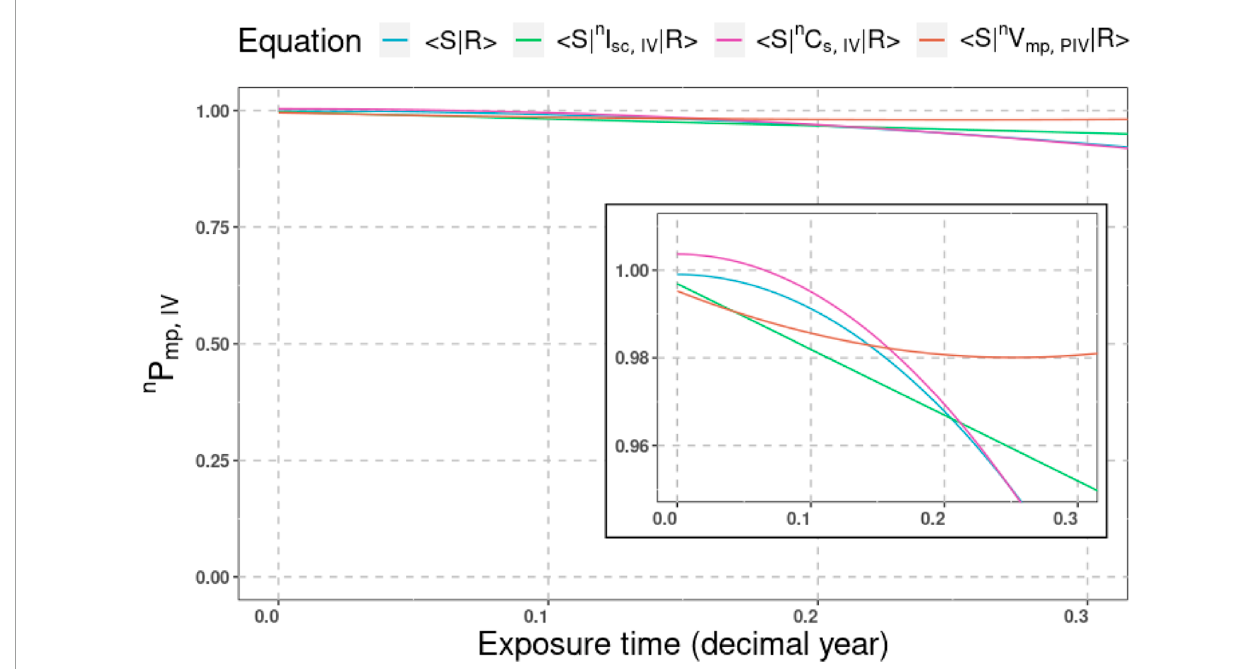
FIGURE 8 Power loss due to mechanisms: GB with EVA by manufacturer B in mDH. Each of the lines correspond to the power loss caused by each mechanistic variable compared to the total power loss. The equations were obtained using Markovian model.